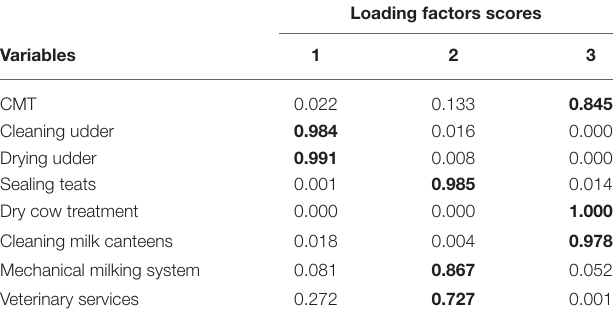
TABLE 11 | Rotated (Varimax) component